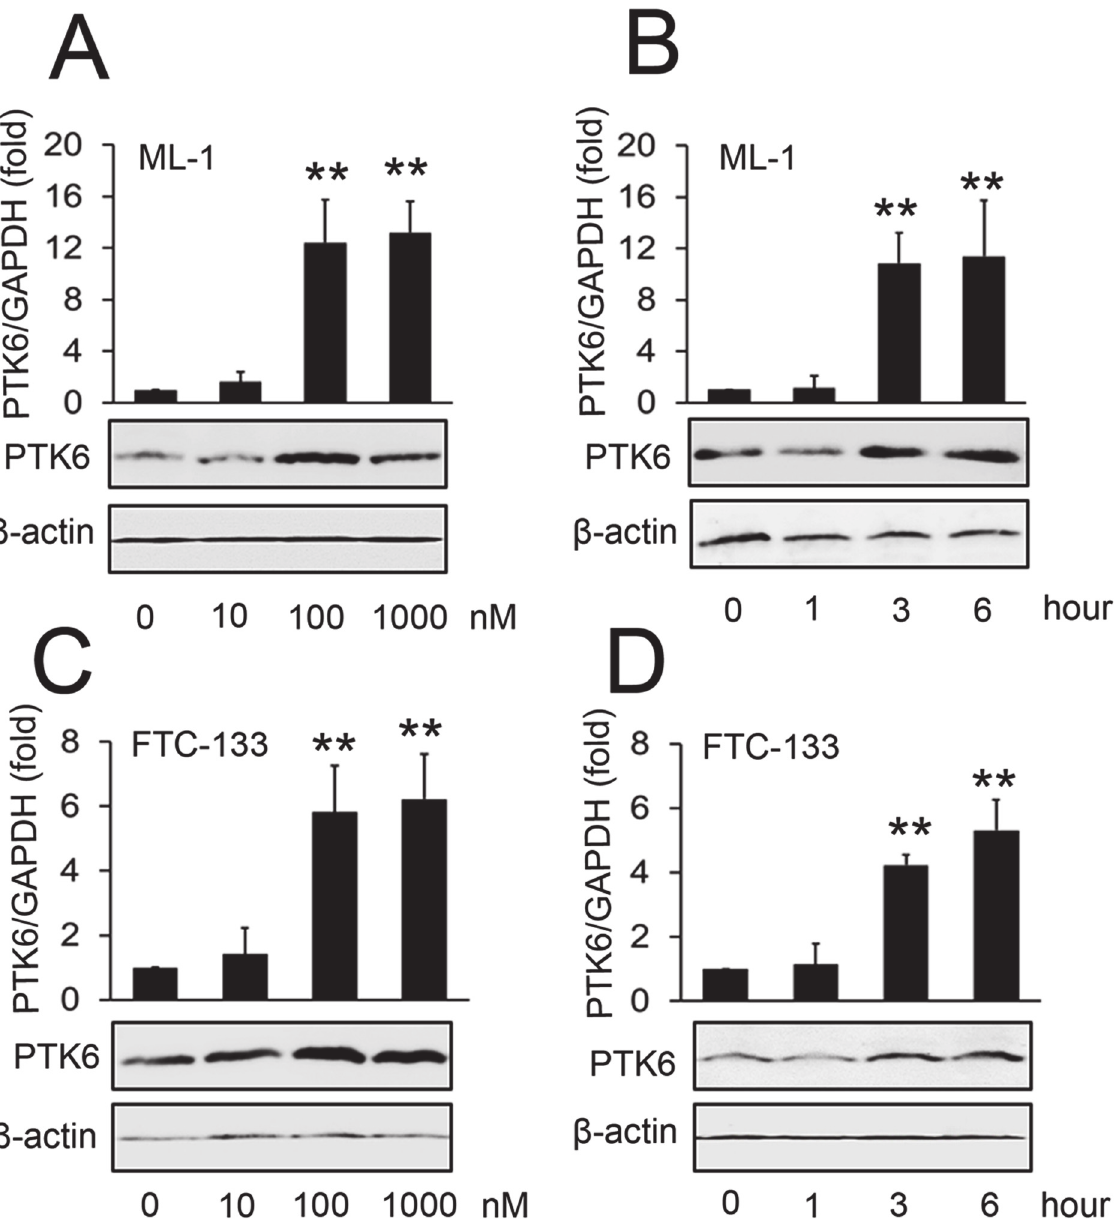
Fig 1. Effect of S1P on the expression of PTK6. (A, C) ML-1 cells (A) and FTC-133 cells (C) were stimulated with the indicated concentrations of S1P for 3 hours. PTK6 RNA levels were quantified by real-time RT-PCR (upper panel) and protein levels of PTK6 were detected by Western blot (lower panel). (B, D) ML-1 cells (B) and FTC-133 cells (D) were stimulated with 100 nM S1P for the indicated times. PTK6 RNA levels were quantified by real-time RT-PCR (upper panel) and protein levels of PTK6 were detected by Western blot (lower panel). Experiments were performed three times with similar results (lower panels of A-D). Data represent means ± SD, n = 3 ( ** P < 0.01; * P <